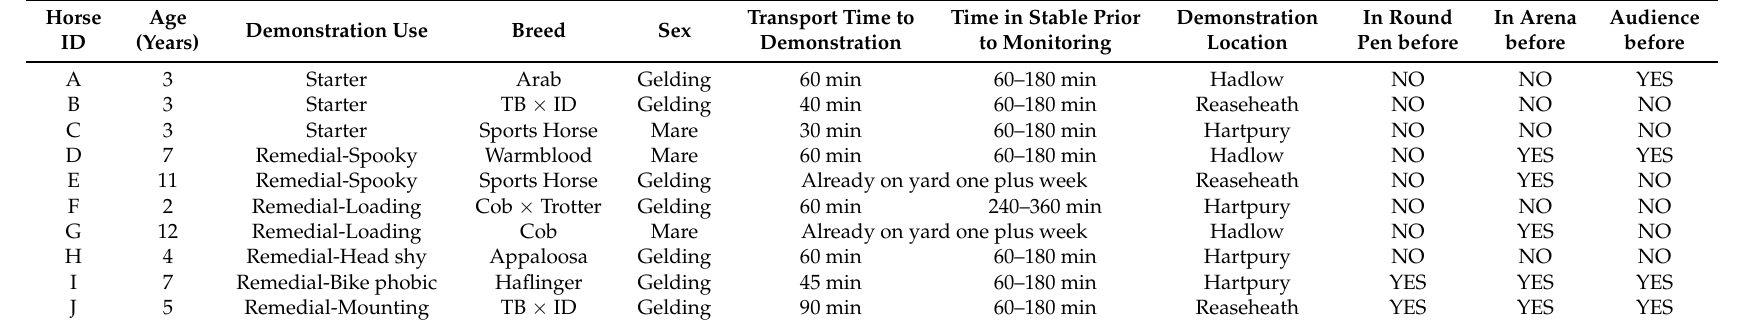
TB: Thoroughbred; ID: Irish Draft; × :